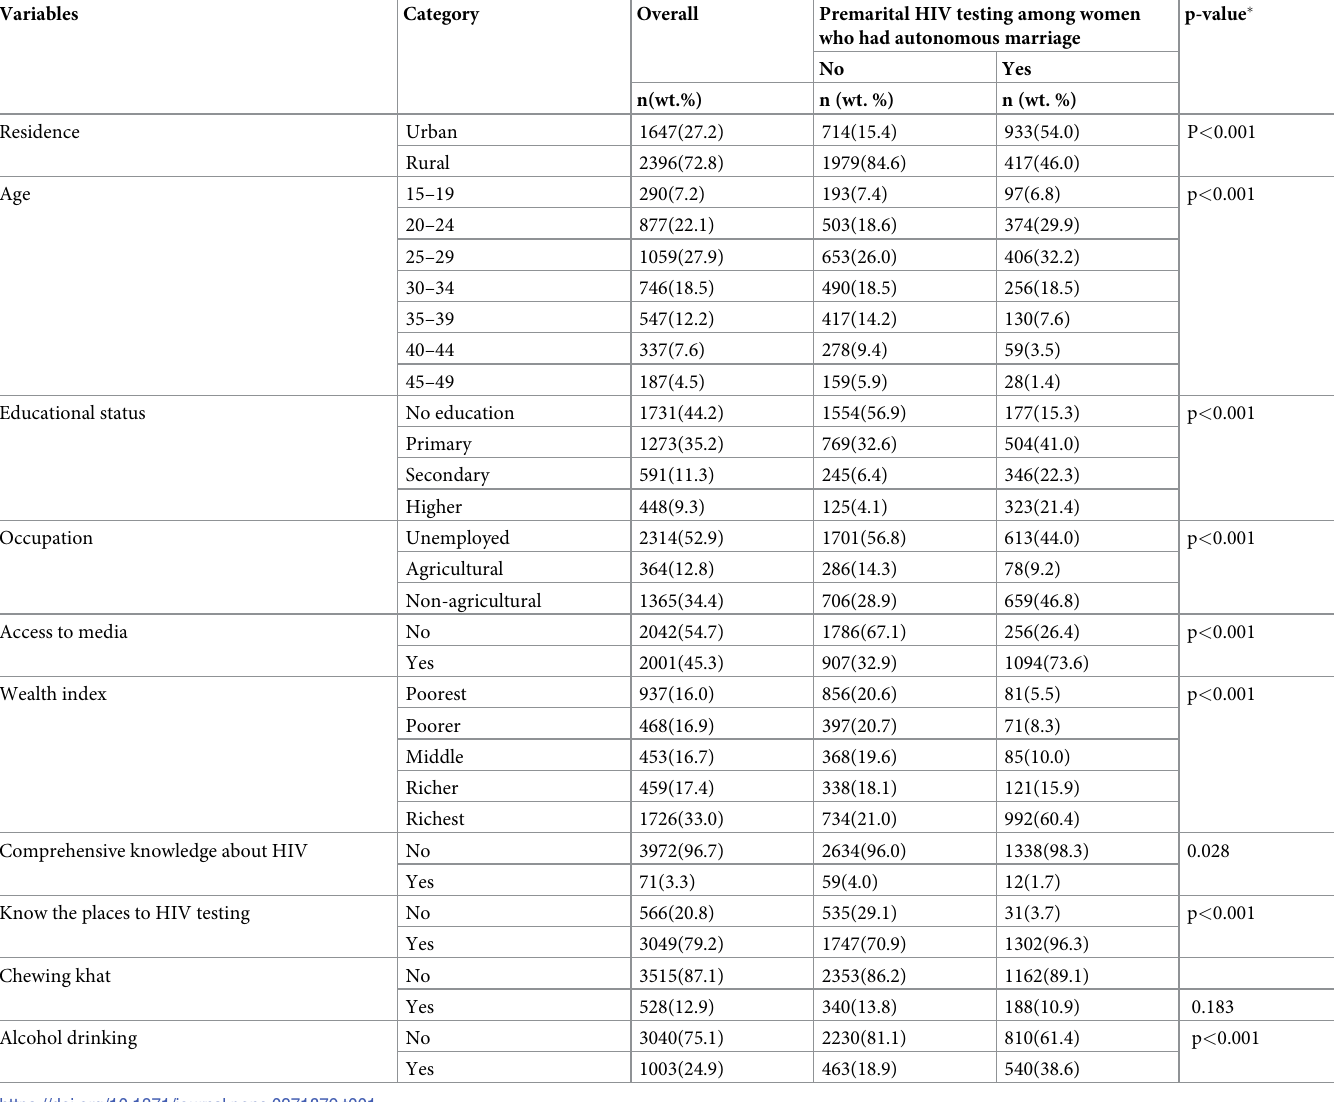
Table 1. Characteristics of the study participants who had autonomous marriage (n =